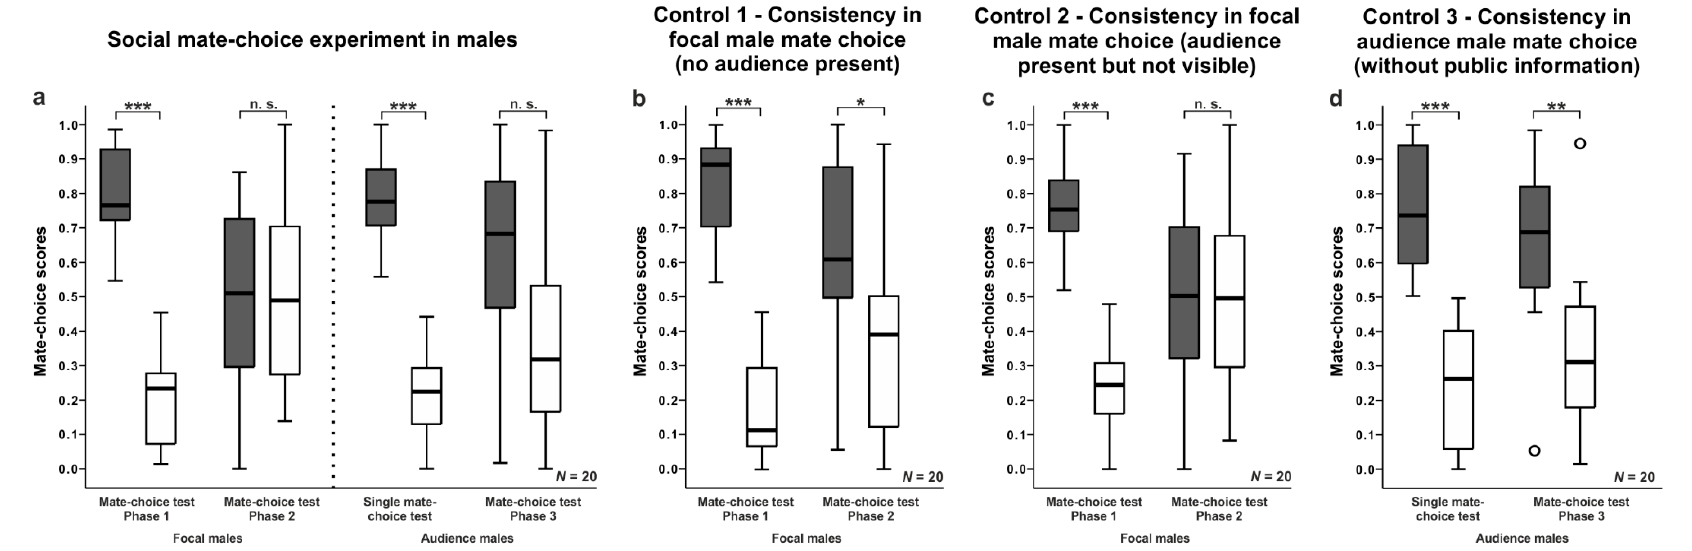
Figure 2. Male mate-choice experiment: Mate-choice scores of focal and audience males for preferred (grey boxplots) and non-preferred (white boxplots) stimulus females in single mate-choice experiments, in social mate-choice experiments, and controls. Boxplots show median, quartiles, and whiskers (1.5 x interquartile range). Circles indicate mild outliers. Significant p -values are from Wilcoxon matched-pairs tests (* p < 0.05; ** p < 0.01; *** p < 0.001; n.s. = non-significant).